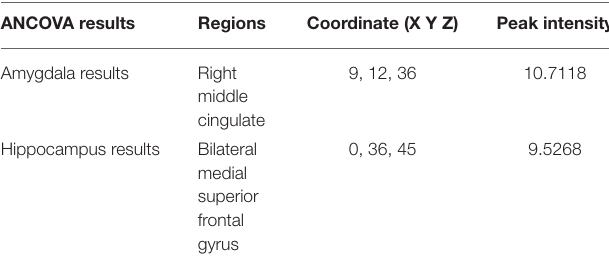
TABLE 2 | Coordinate of significant regions in ANCOVA